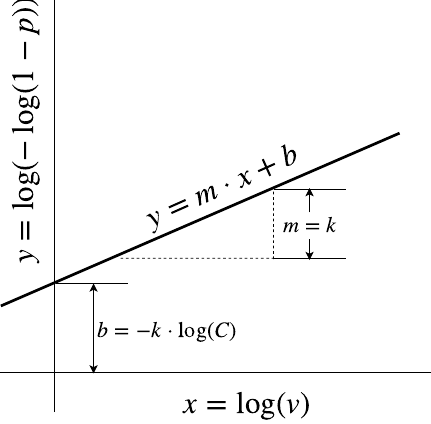
Figure 1. Representation of Equation (5) in the form of a straight